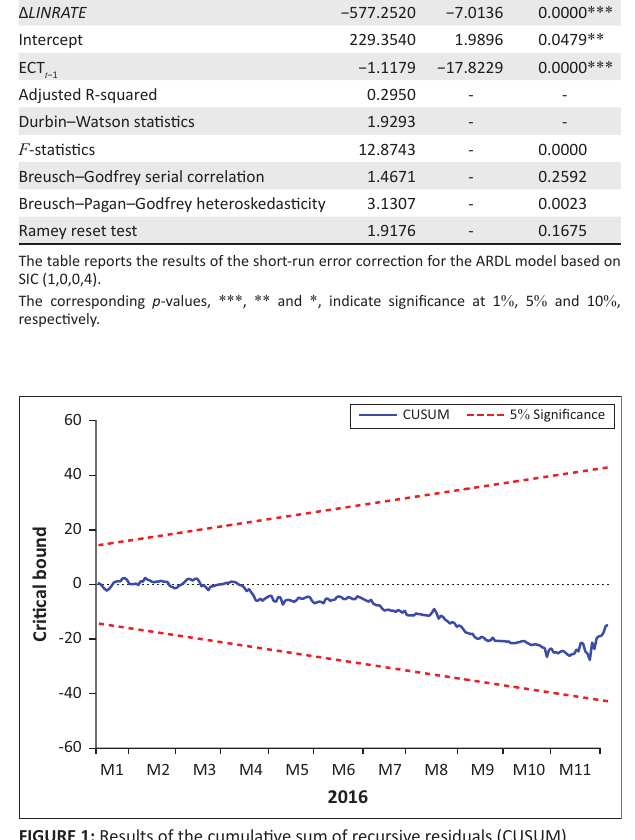
FIGURE 1: Results of the cumulative sum of recursive residuals (CUSUM).